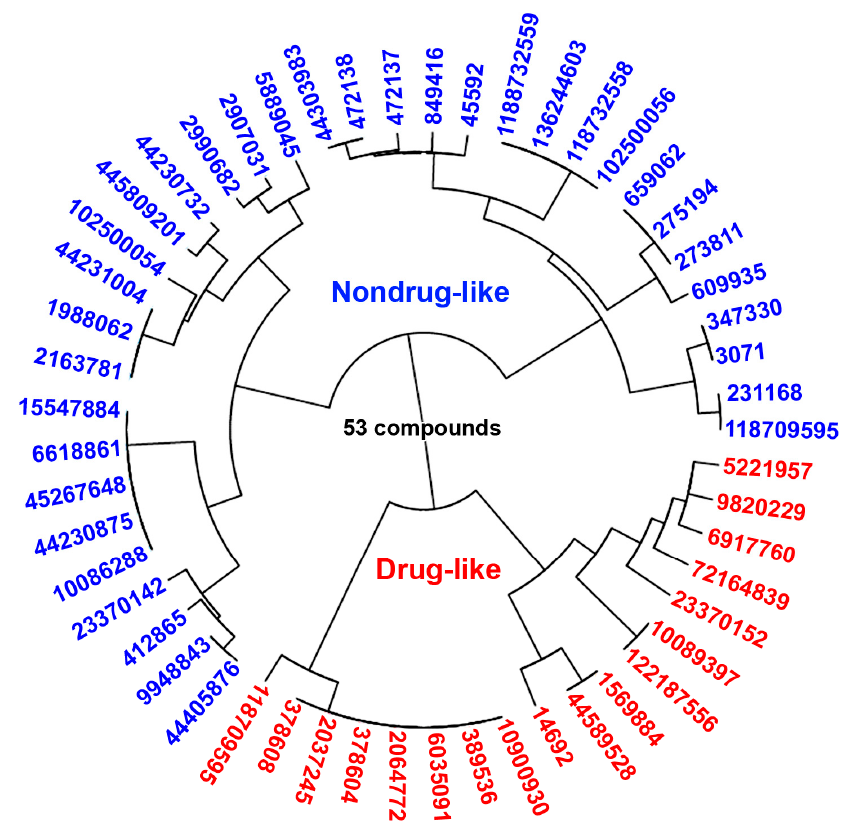
Figure 5. The statistical machine learning predictions and classified the 53 pharmacophore hit candidate molecules as a drug-like (18) and nondrug-like (35) compounds.